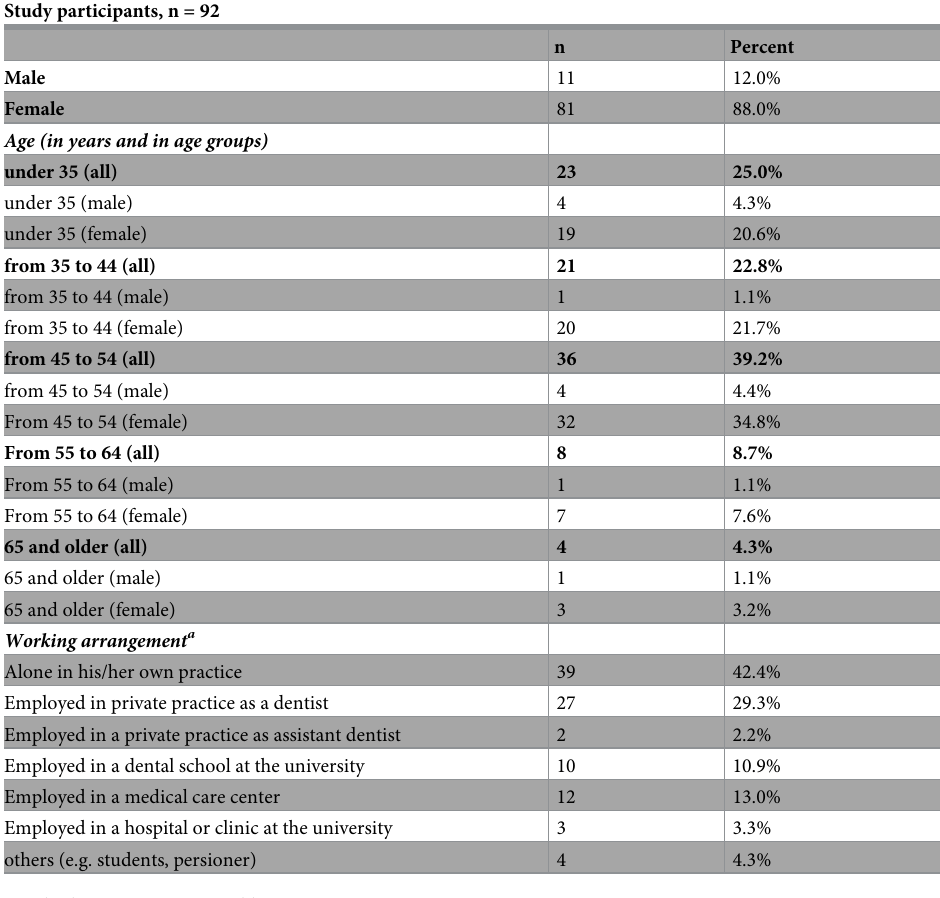
Table 1. Study participants, frequencies and